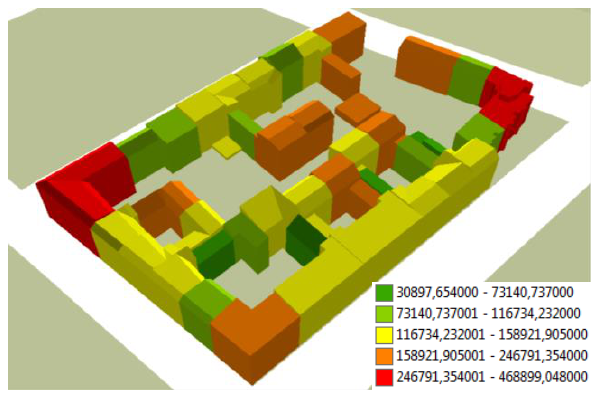
Figure 3. 3D visualisation of coloured buildings regarding the estimated annual heating energy demand